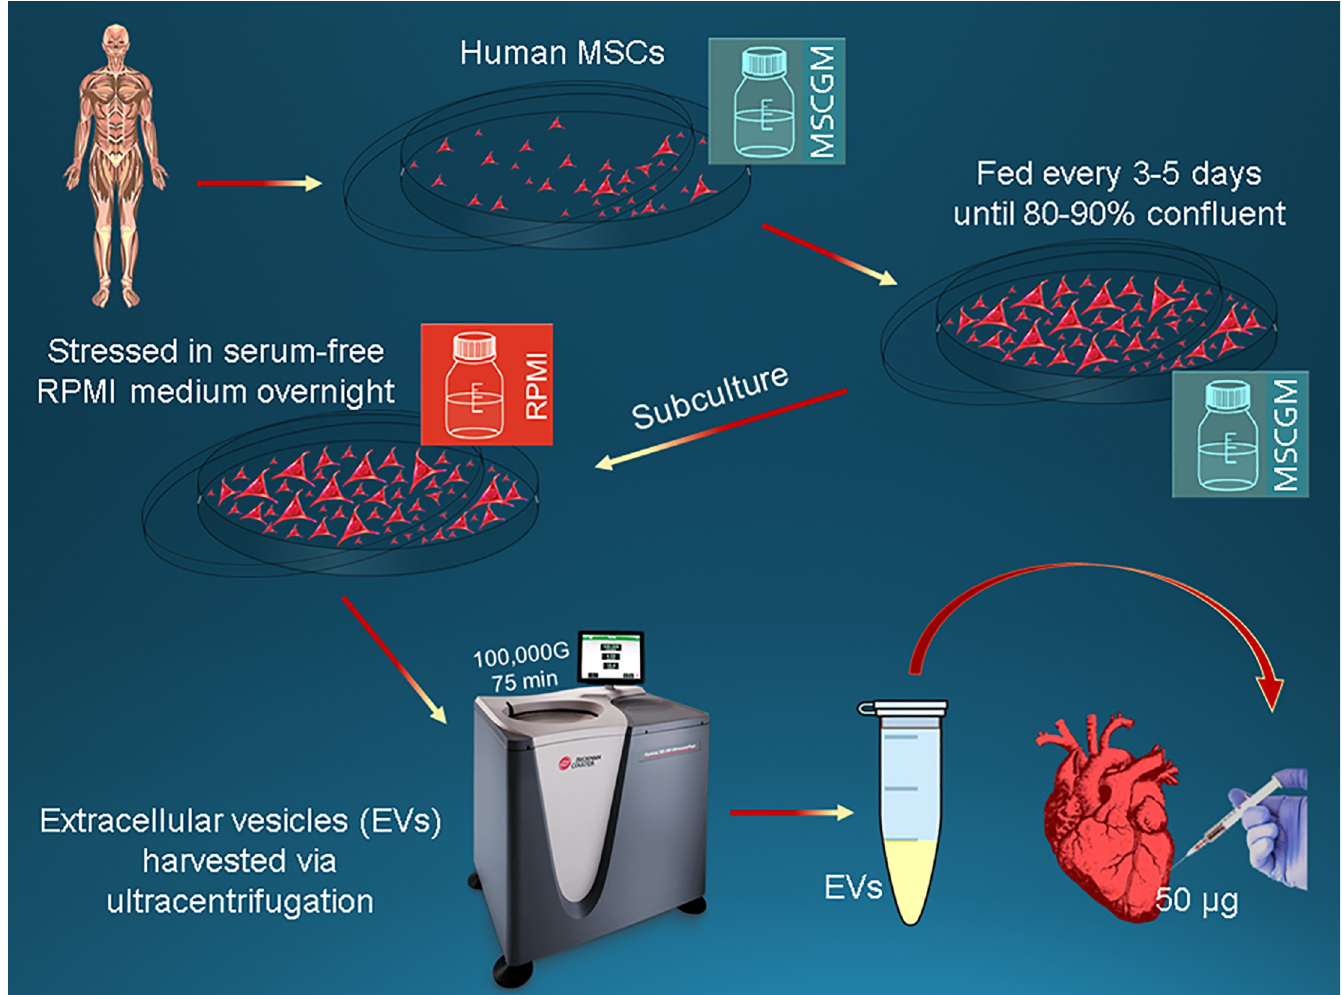
Fig 1. Extracellular vesicle isolation. Schematic of cell culturing of human bone-marrow derived mesenchymal stem cells, stress, and isolation of extracellular vesicles. https://doi.org/10.1371/journal.pone.0238879.g001 PLOS ONE | https://doi.org/10.1371/journal.pone.0238879 September 11,